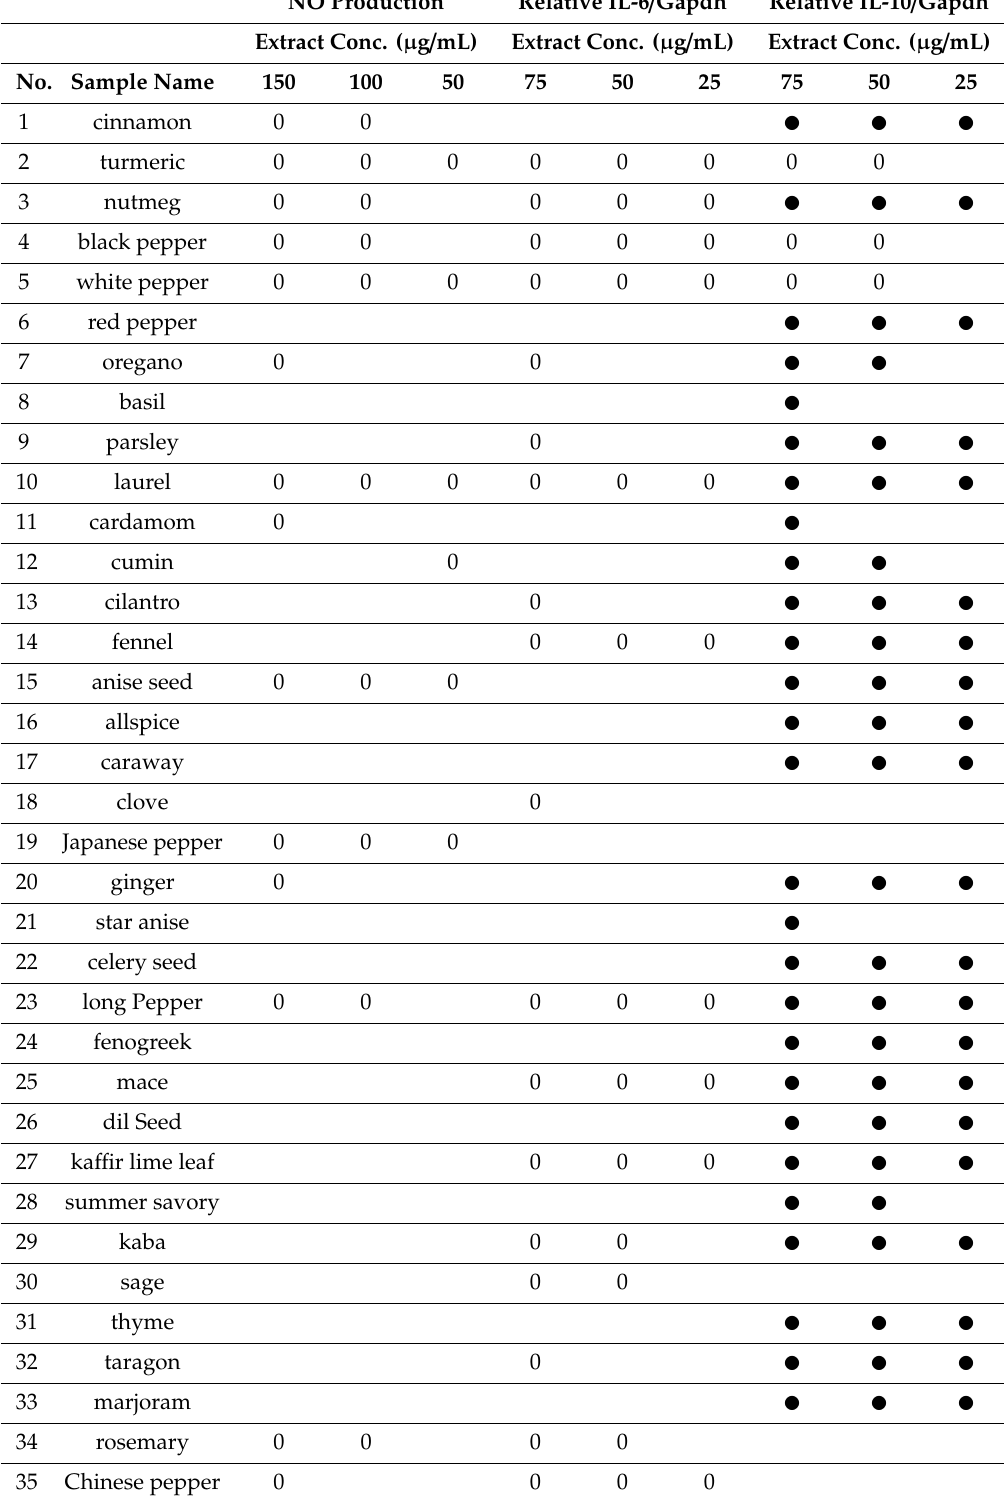
Table 1. The summary of results from anti-inflammation screening assays. NO Production Relative IL-6 / Gapdh Relative IL-10 / Gapdh Extract Conc. ( µ g / mL) Extract Conc. ( µ g / mL) Extract Conc. ( µ g /